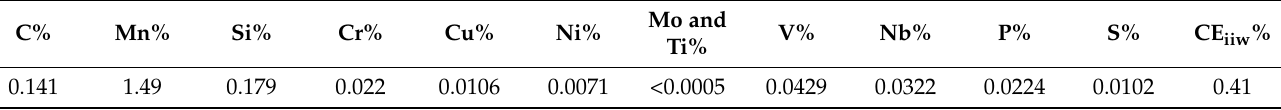
Figure 1. Simulated specimen with dimensions of 10 mm × 10 mm × 71 mm presenting the IC CGHAZ zone that is located in the central part of the sample with a width of approximately 8 mm. Table 1. Chemical composition of the ASTM DH36 steel in wt.%.